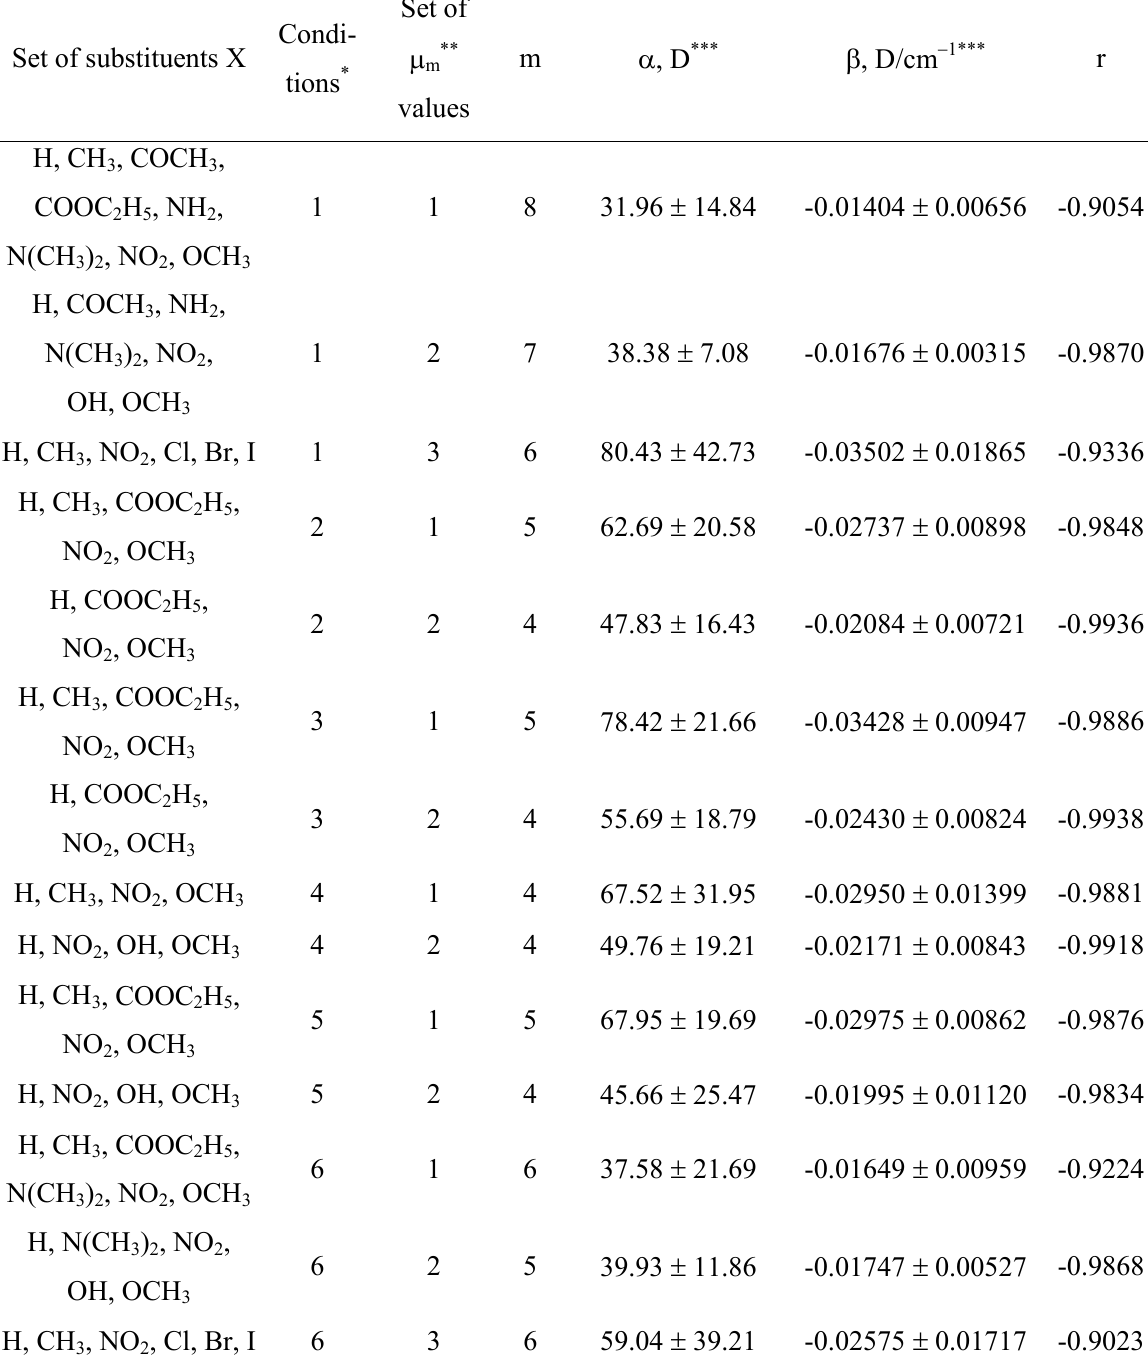
H N + ≡ N [16, 18-20] 6 4